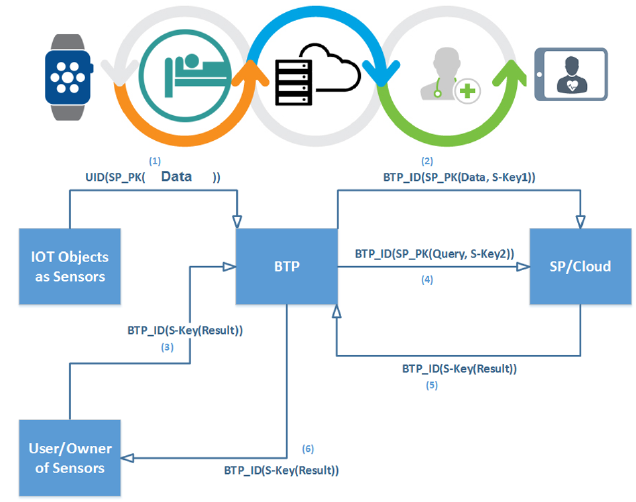
Figure 22. Blind Approach with E-health